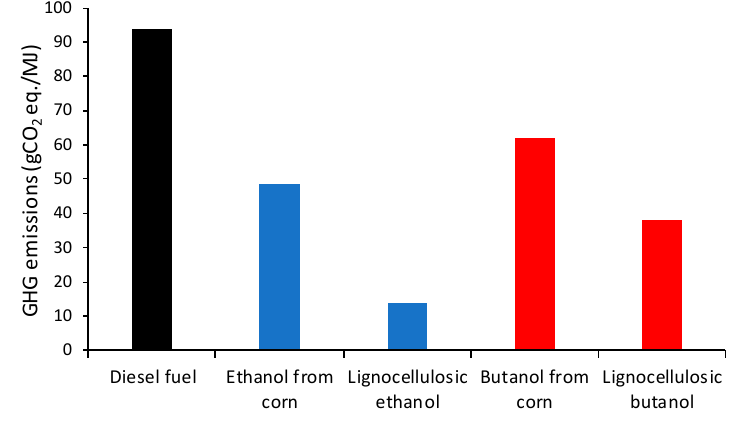
Figure 2. GHG emissions. Based on [13].